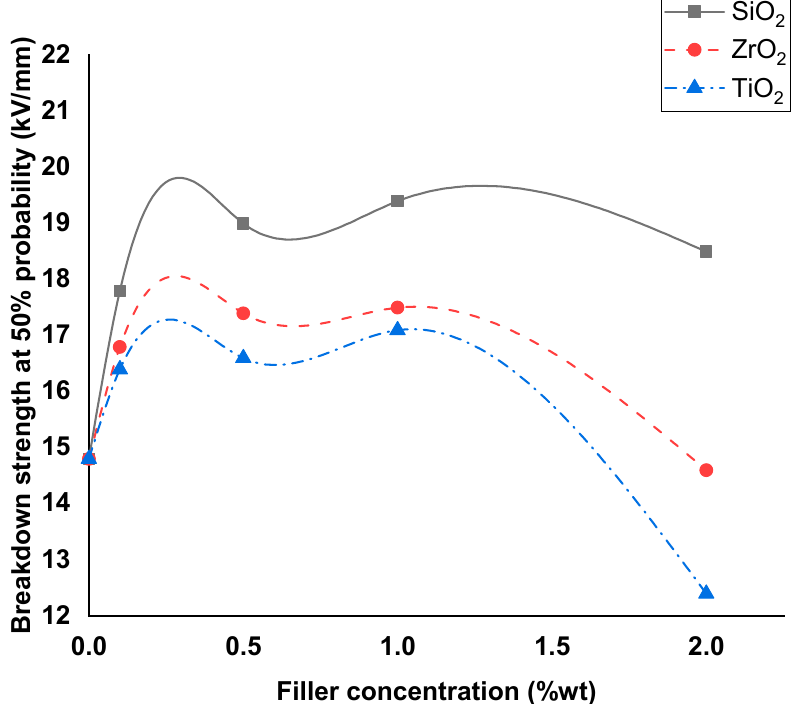
Figure 12. Breakdown strength at 50% probability of silicone rubber containing different types of nanoparticles (SiO 2 , ZrO 2 and TiO 2 ).